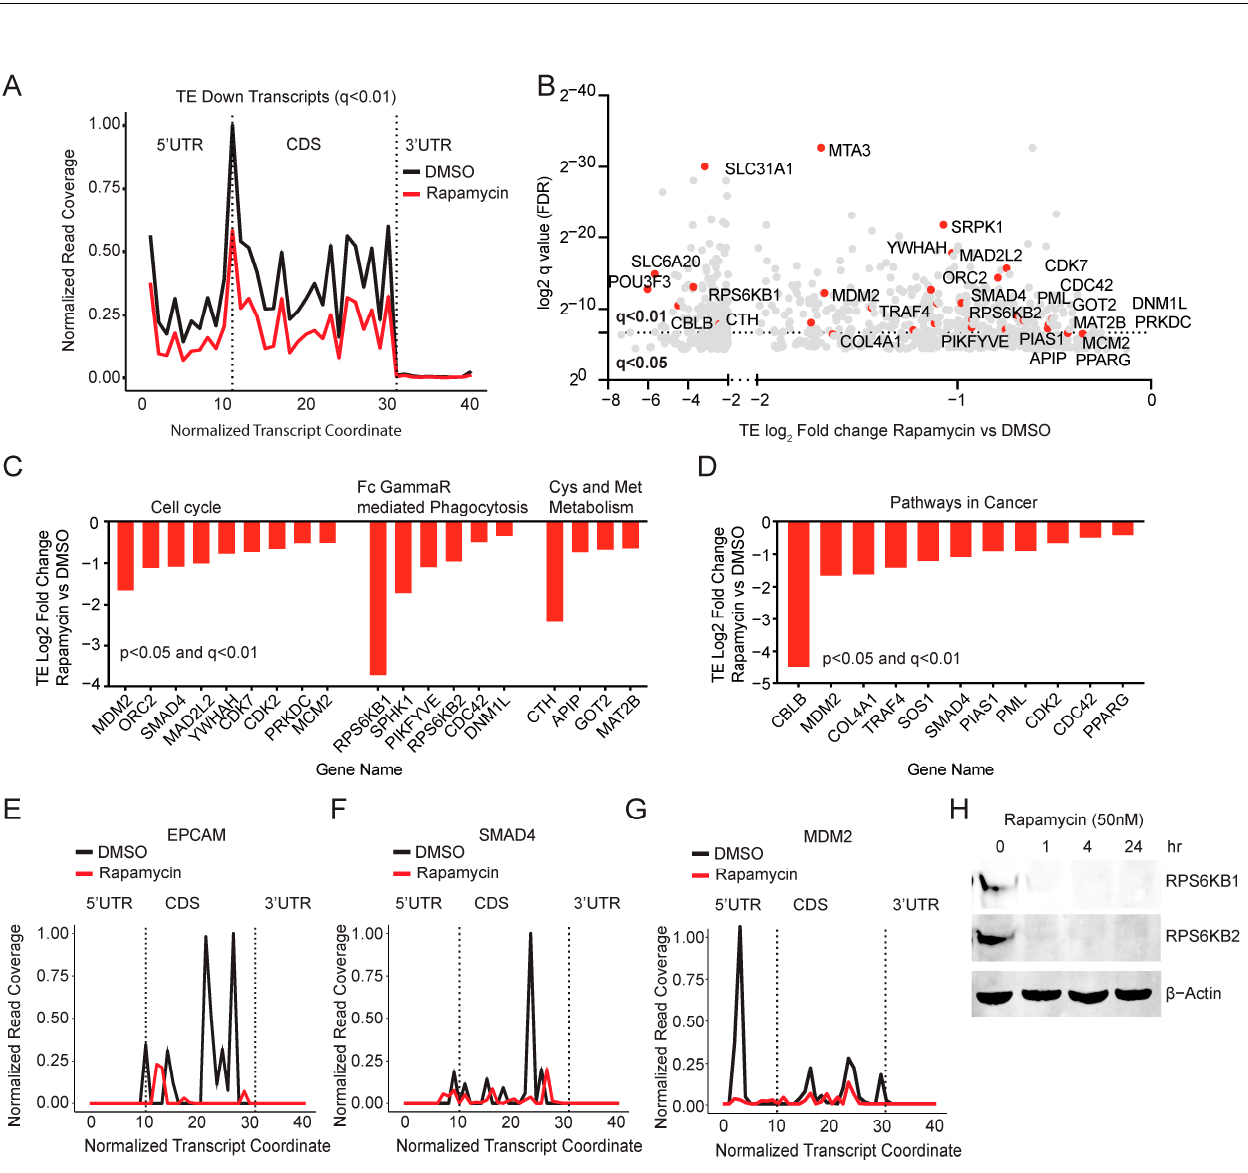
Figure 2. Rapamycin inhibits the translation of genes involved in the cell cycle and cancer cell growth. ( A ) Metagene plot showing a reduction in ribosome read coverage throughout the mRNA length in the TE down mRNAs (q < 0.01) in rapamycin-treated PANC-1 cells compared to the DMSO. RF coverage and transcript length are normalized for comparison. ( B ) TE down genes ranked by q value. Translational targets involved in the cell cycle and cancer growth are highlighted in red. ( C , D ) TE (log2-fold change) of key genes involved in cell cycle, Fc gamma receptor-mediated phagocytosis, Cys and Met metabolism, and pathways in cancer. ( E – G ) Ribosome coverage is reduced throughout the mRNA length in EPCAM, SMAD4, and MDM2 in rapamycin-treated PANC-1 cells compared to the DMSO. RF coverage and transcript length are normalized. ( H ) Immunoblot showed a reduction in the total protein of RPS6KB1 and RPS6KB2 following rapamycin treatment (50 nM) for the indicated time points. b-actin is used as the loading